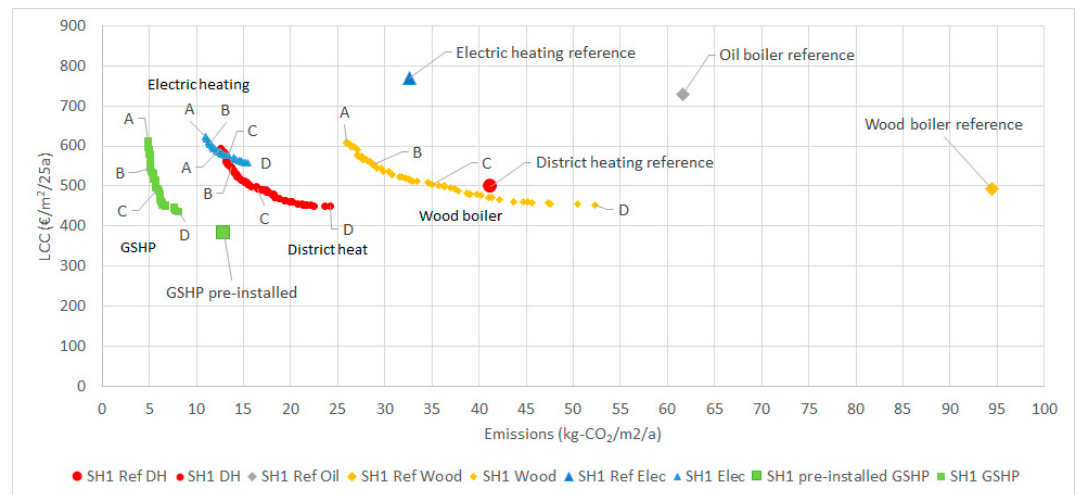
Figure 8. Reference cases and optimal results for the oldest single-family house SH1 with different heating systems. The cost and emissions of the reference cases are shown with large individual symbols. The corresponding optimal results are shown as Pareto fronts with the same color. Four individual solutions were chosen from each Pareto front, identified with the letters A to D. A is the most expensive solution, and D the least cost solution, with B and C equally distributed between them.